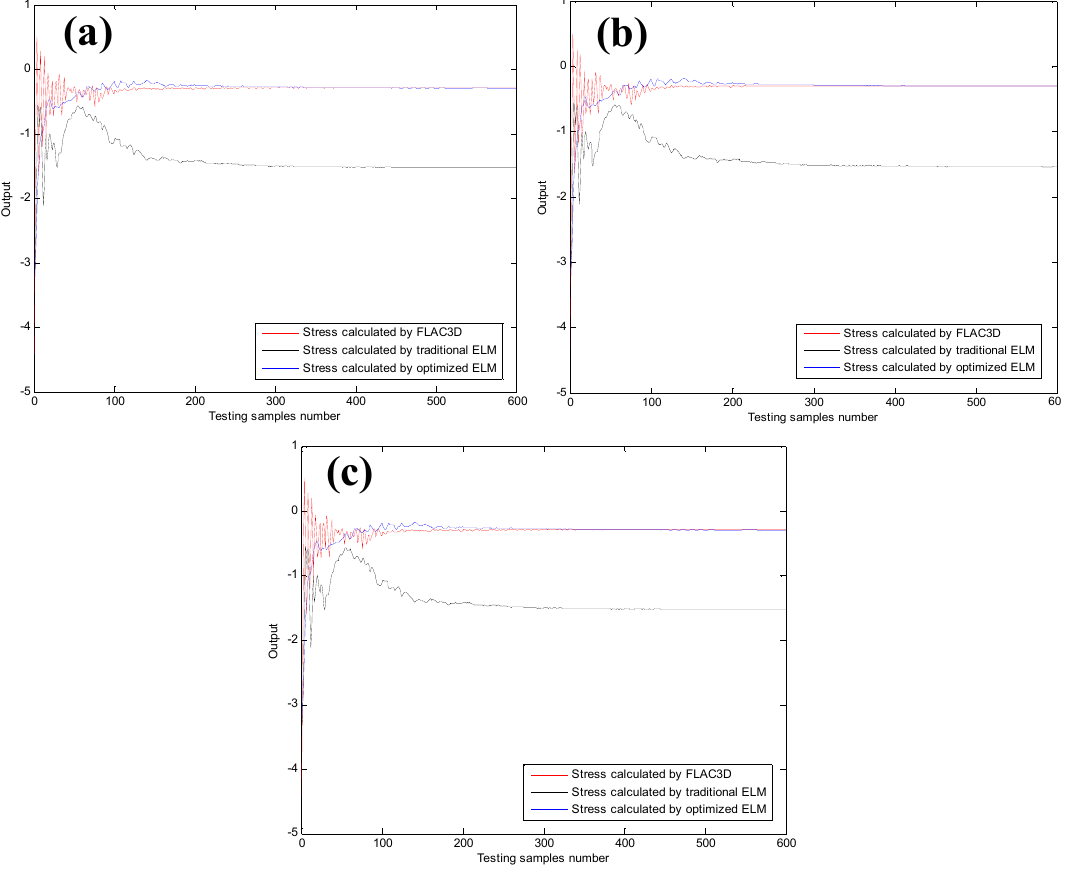
Figure 6. Comparison of Z-direction stress among predictive models and FLAC3D in ( a ) cross-section 7 < y < 8, and ( b ) 13 < y < 14 and ( c ) 17 < y < 18.